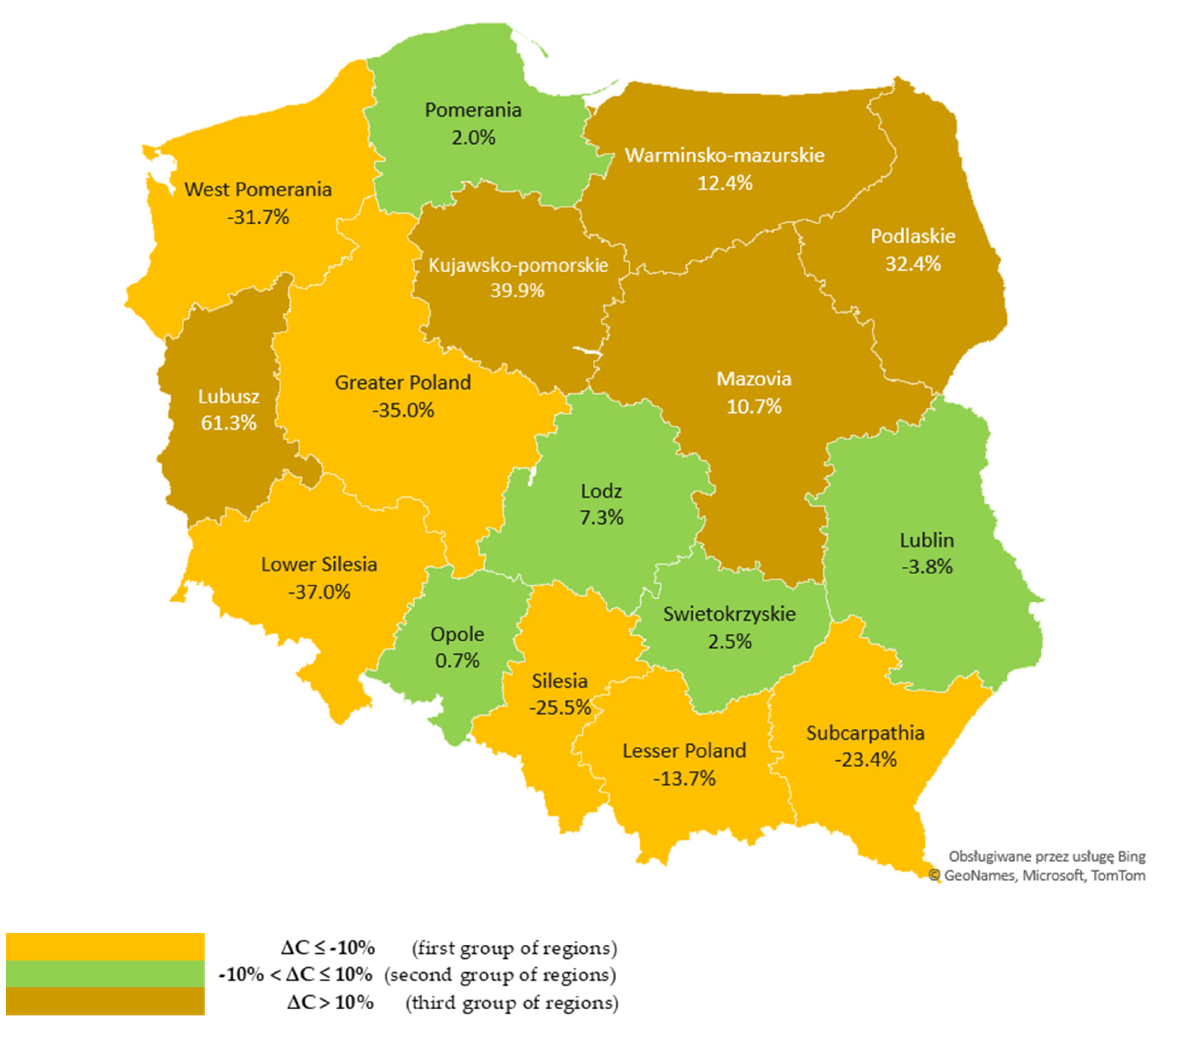
Figure 3. Relative cumulative percentage change in CO 2 emissions ( ∆ C) in Polish regions from 2010 to 2019 (in relation to 2010 levels). Source: own elaborations.